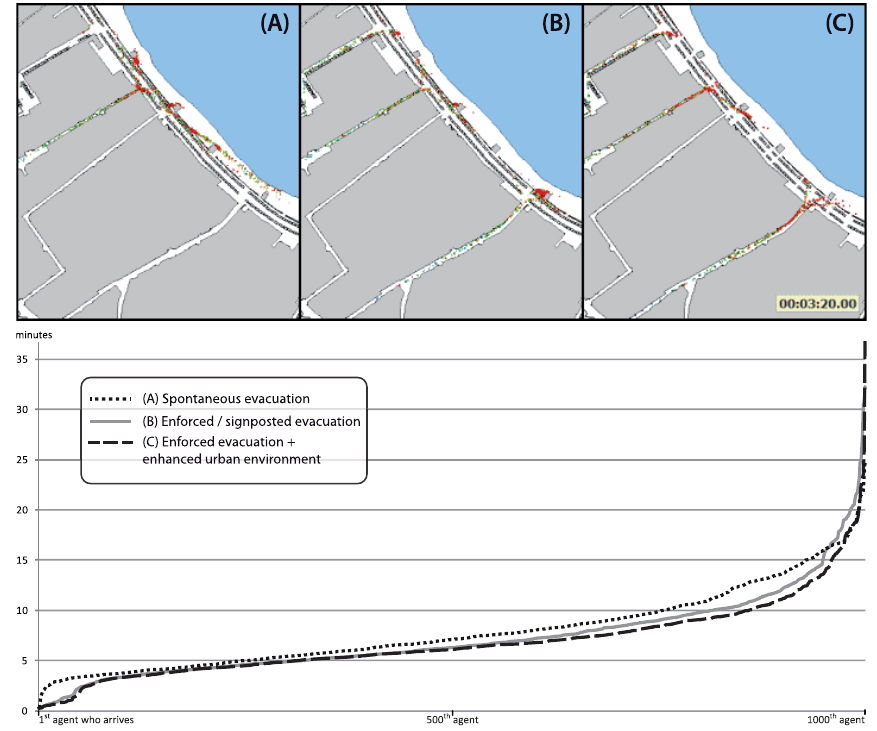
Fig. 11. Micro-simulation results for the three different scenarios and extract of the simulations after 3min and 20s.